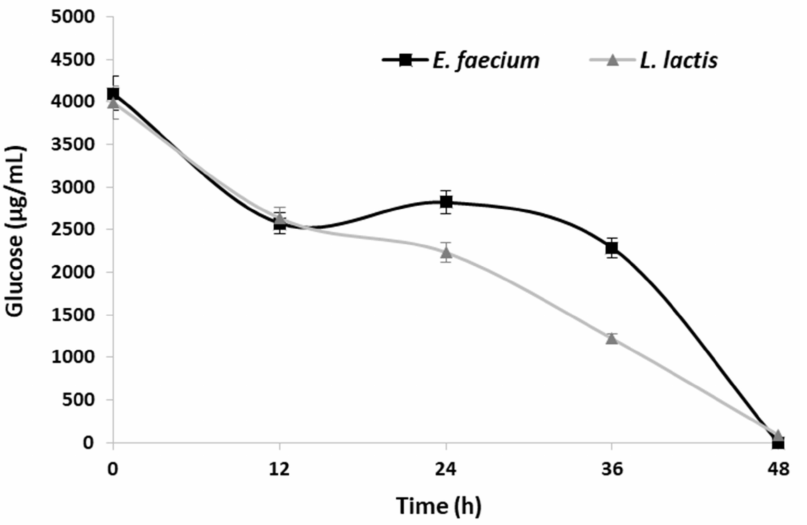
Figure 4. Profile of glucose during fermentation of the Aloe vera juice by Enterococcus faecium (black) and Lactococcus lactis